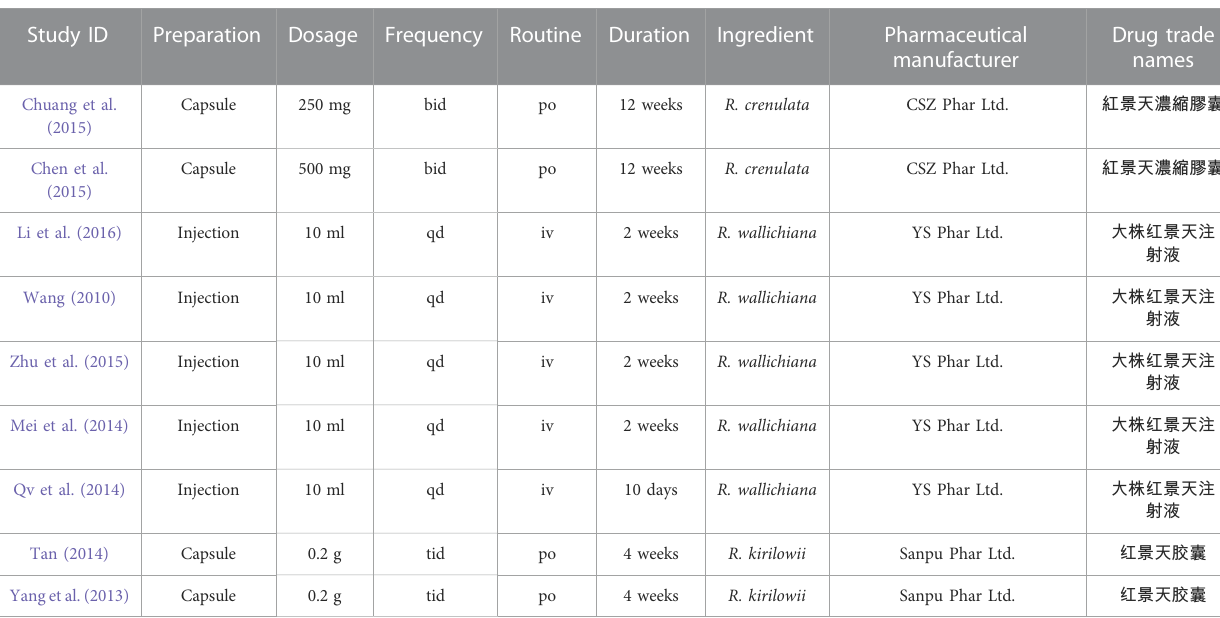
TABLE 2 Summary of intervention treatments.